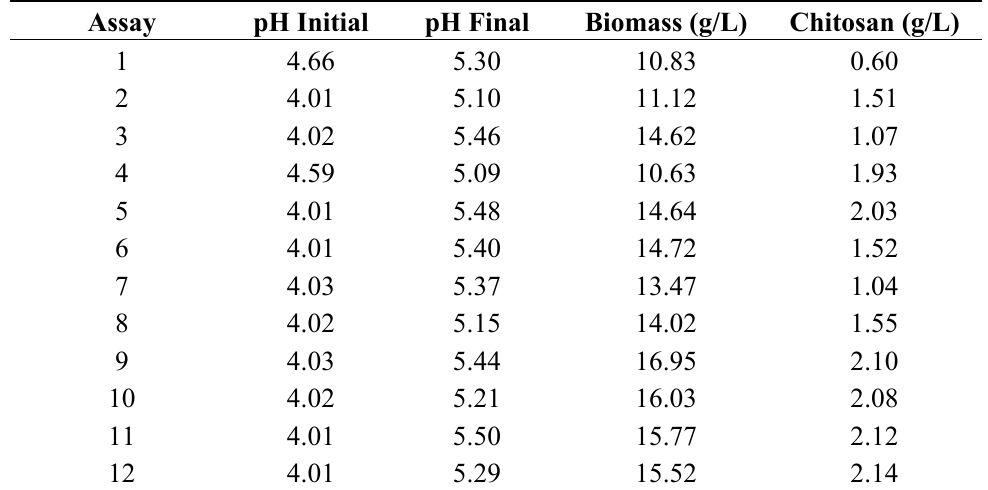
Experimental design 2³ for the production of biomass and chitosan: Asparagine %: − 1 (0); 0 (0.025); 1